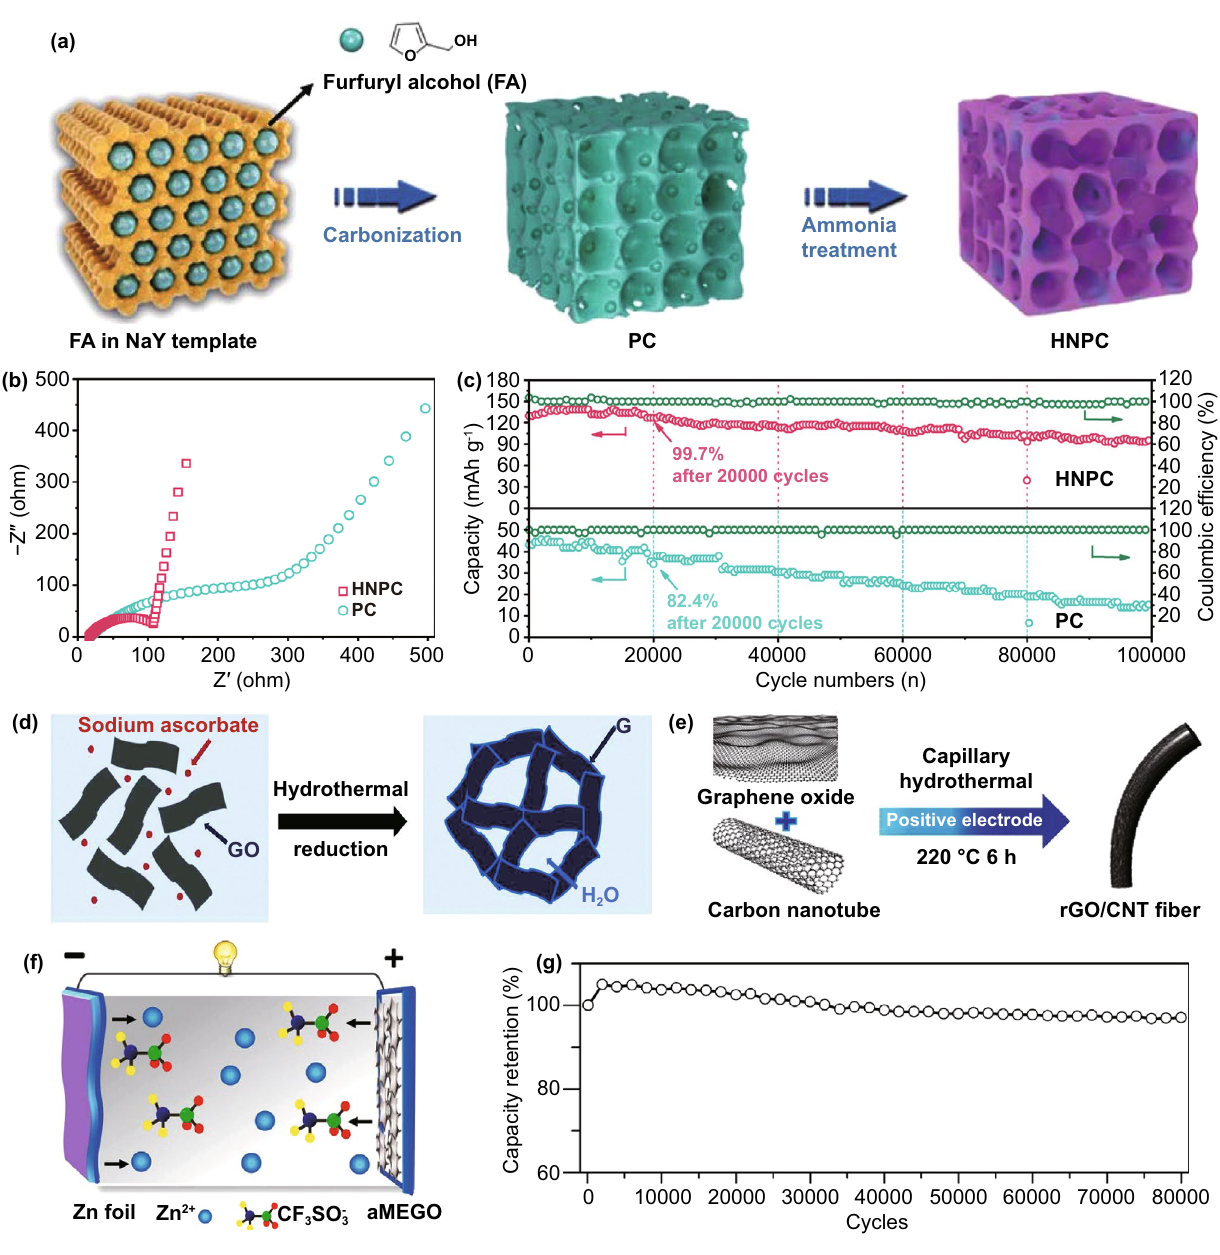
Fig. 5 a Schematic illustration of the synthesis route of the HNPC. b Nyquist plots and c cycling performance at 16.7 A g −1 of the Zn//PC and Zn//HNPC ZHSCs. Reproduced with permission from Ref. [85]. Copyright 2019, Wiley–VCH. d Schematic of the preparation process of 3D graphene by hydrothermal reduction. Reproduced with permission from Ref. [131]. Copyright 2018, Royal Society of Chemistry. e Schematic illustration of the synthesis of rGO/CNT. Reproduced with permission from Ref. [120]. Copyright 2019, Wiley–VCH. f Schematic illustration of discharging process and g cycling performance of the Zn//aMEGO ZHSCs. Reproduced with permission from Ref. [82]. Copyright